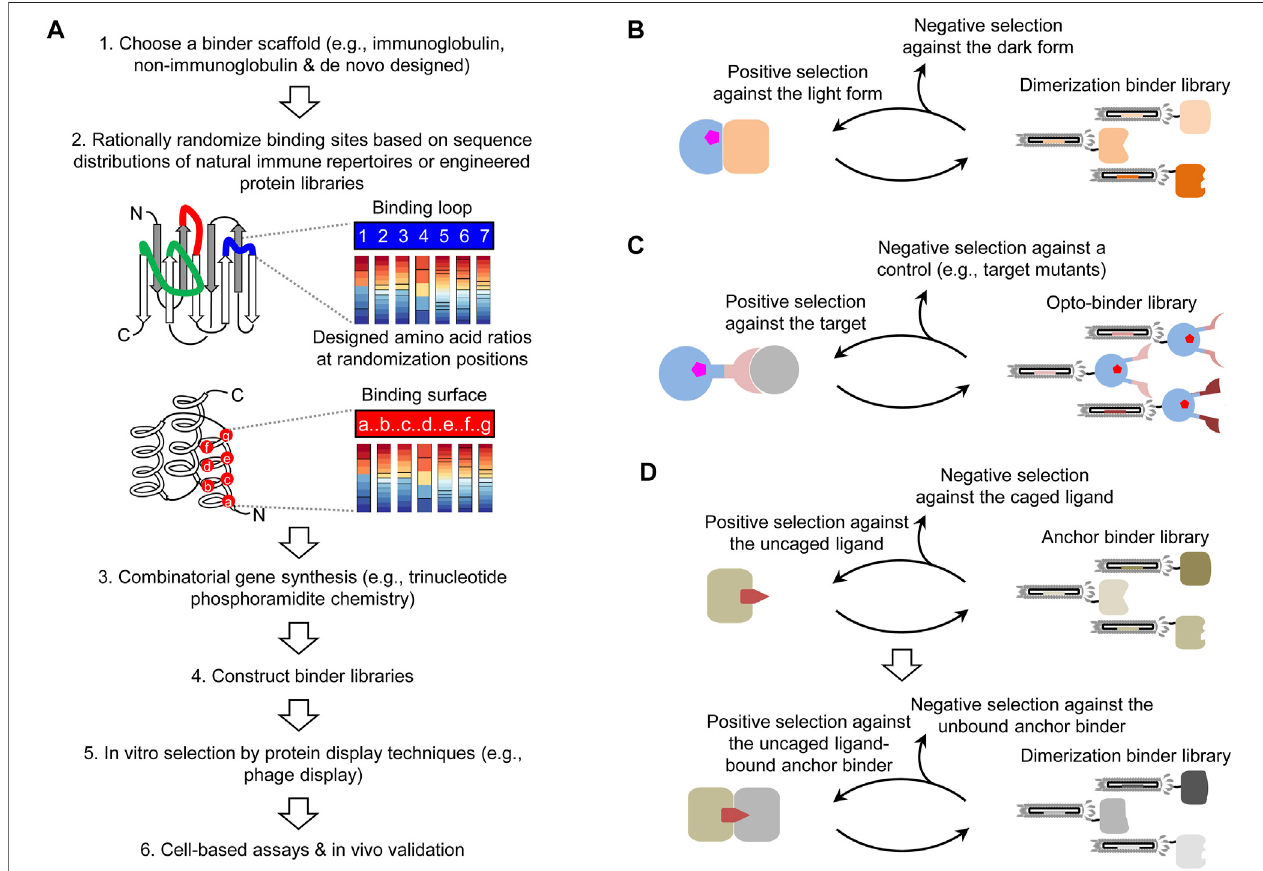
FIGURE 2 | Combinatorial approaches for creating photoswitchable dimerization systems. (A) Pipeline of the design and screening of combinatorial binder libraries. (B) Combinatorial approach for obtaining dimerization binders in a photoswitchable heterodimerization system. (C) Selection of a combinatorial optobinder library constructed with a binder scaffold inserted with a photoreceptor for the allosteric regulation. The opto-binder library is applicable to arbitrary targets. (D) Generalizable, two-step approach for creating CID systems for an uncaged ligand.